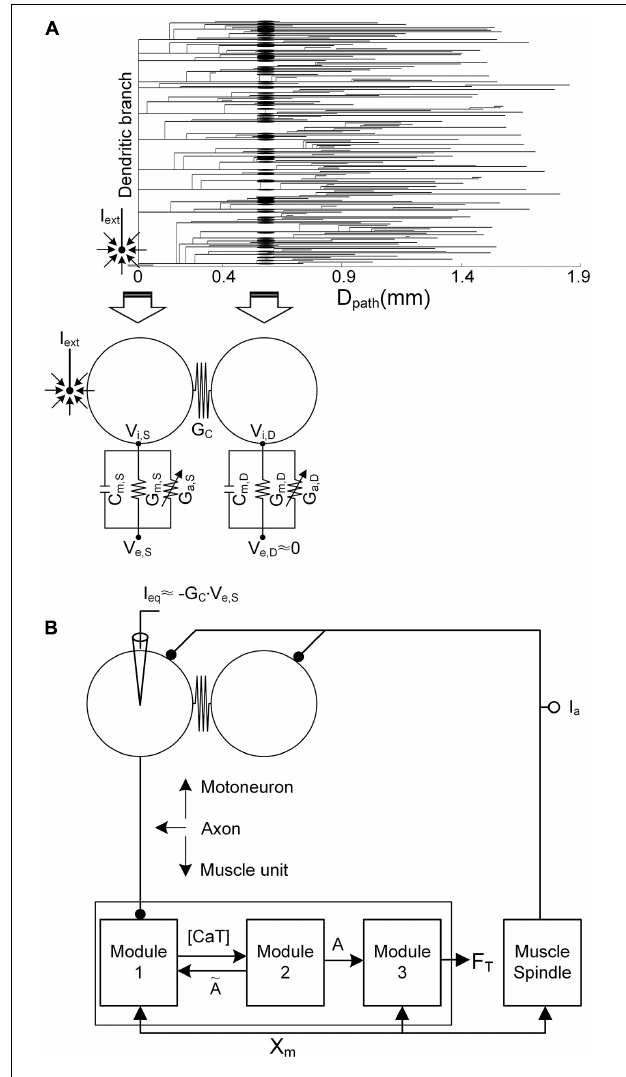
FIGURE 1 | Simulation setup. (A) Reduction in the anatomical motoneuron ( top , dendrogram) into a two-compartment framework ( bottom ) as a function of the path length ( D path ) from the center of the cell body ( D path = 0). The left arrow indicates the mapping of the soma/axonal hillock/initial segment of the anatomical model into the somatic compartment of the reduced model. The right arrow indicates the mapping of all points over the narrow band (a mean value of 0.6 mm) of the anatomical dendrites into the dendritic compartment of the reduced model. C m , G m , G a G C , V i , and V e indicate the membrane capacitance, leak conductance, voltage-gated conductance, coupling conductance, and intracellular and extracellular potentials, respectively. The subscripts S and D indicate the somatic and dendritic compartments, respectively. I ext , the current passing through the microelectrode, is located close to the initial segment and cell body. In the current analysis, V e , S is determined by I ext , while the influence of I ext on V e , D is assumed to be negligible. (B) Model motor unit comprising the two-compartment motoneuron model and three-module muscle unit along with the muscle spindle afferent ( I a ). I eq is the equivalent current intracellularly injected at the somatic compartment of the motoneuron to evoke the same transmembrane potential induced by I ext . [CaT], A , F T , and X m indicate the concentration of calcium bound to troponin, the muscle activation level, the force output, and the muscle length,